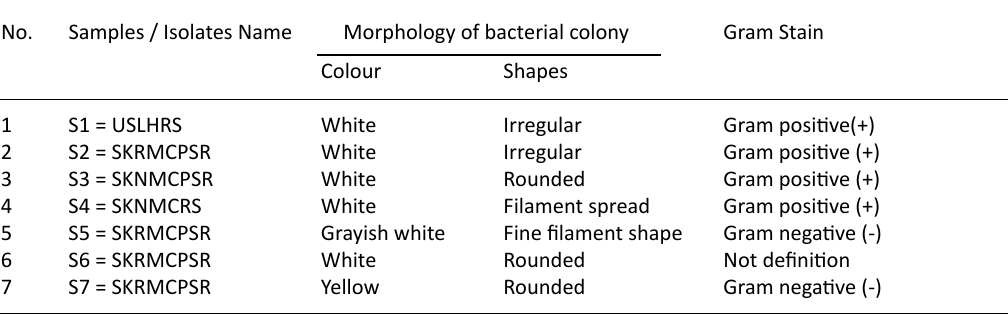
Table 5. Morphological characteristics of colonies of bacterial isolates from flies. No.